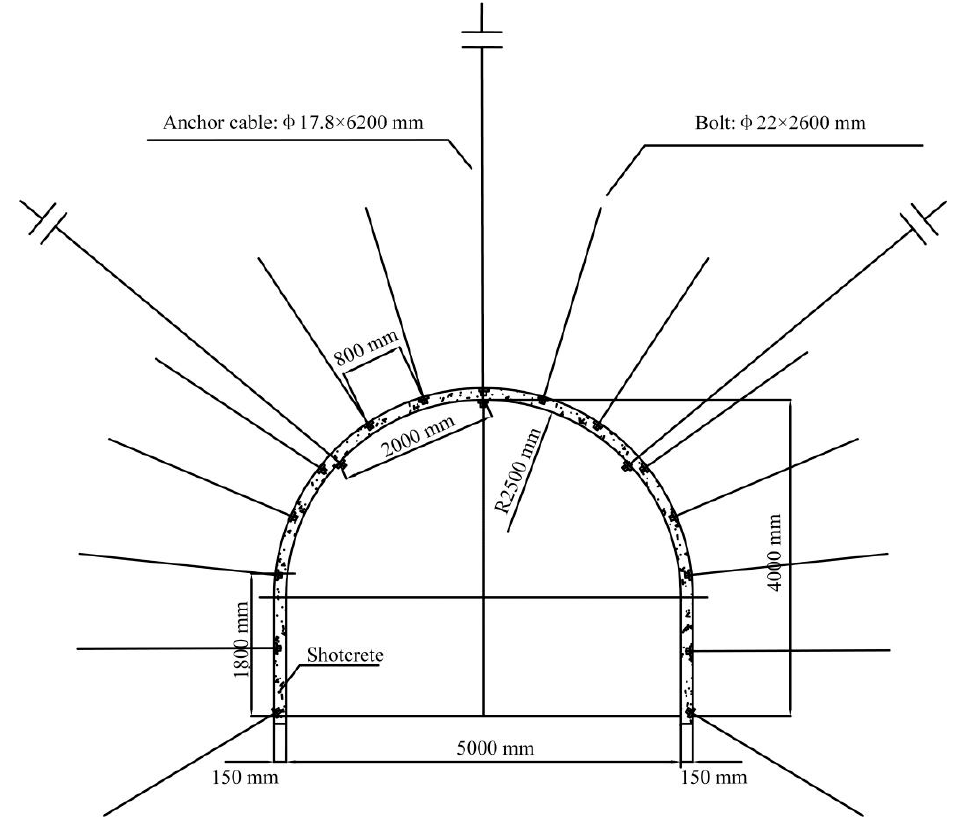
Figure 3. Initial supporting design of the roadway.